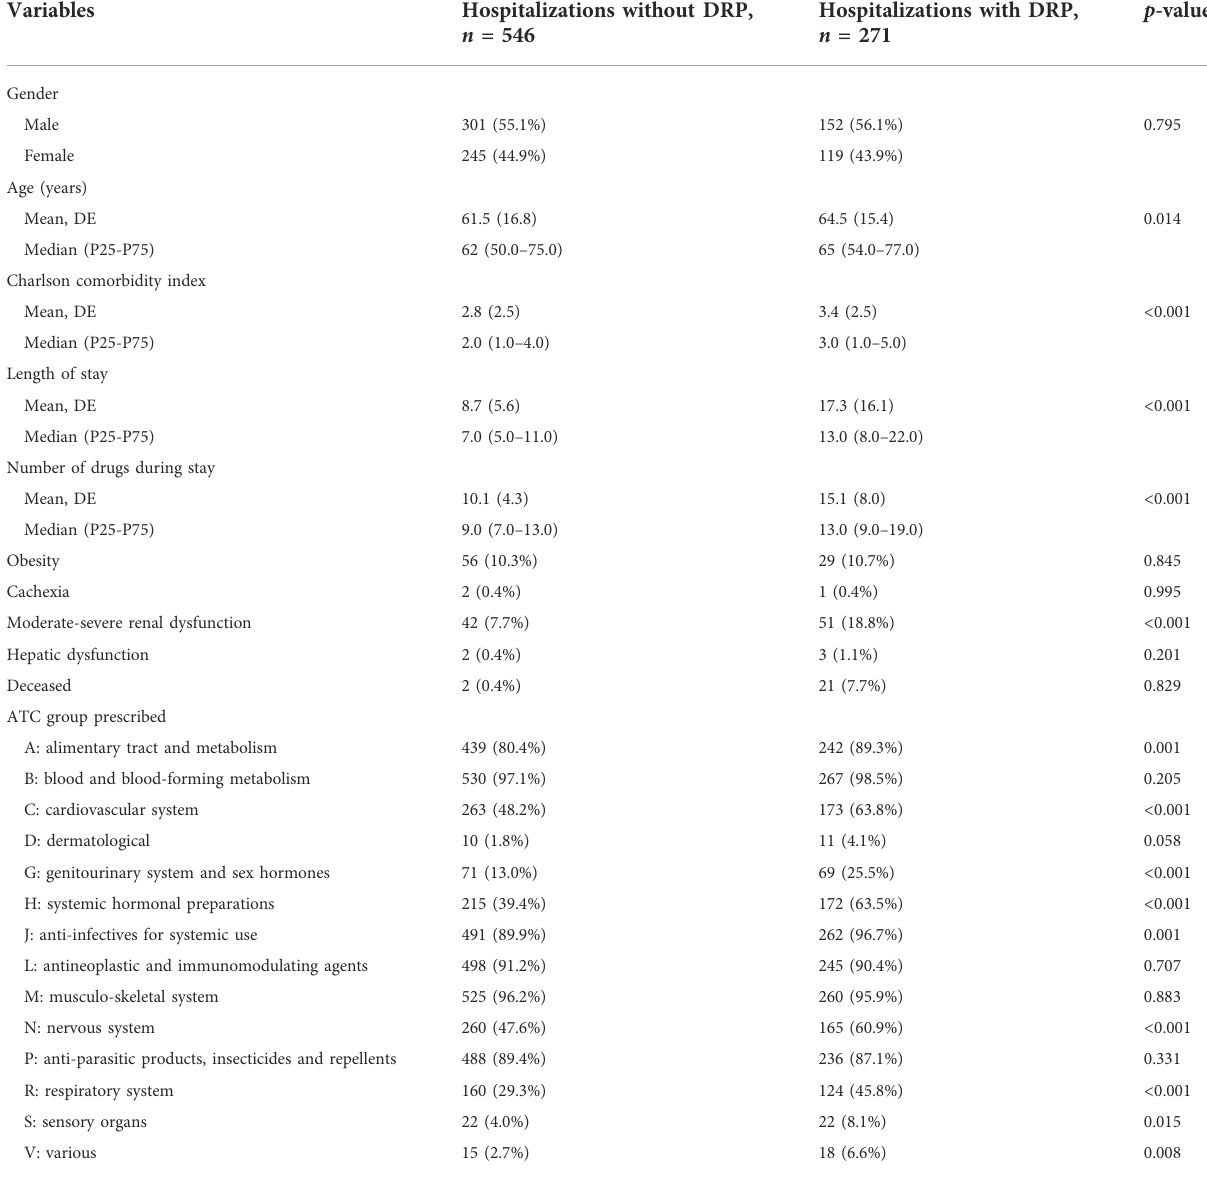
TABLE 1 Bivariate analysis. Demographic and clinical characteristics of patients presenting at least one DRP vs. patients not presenting any